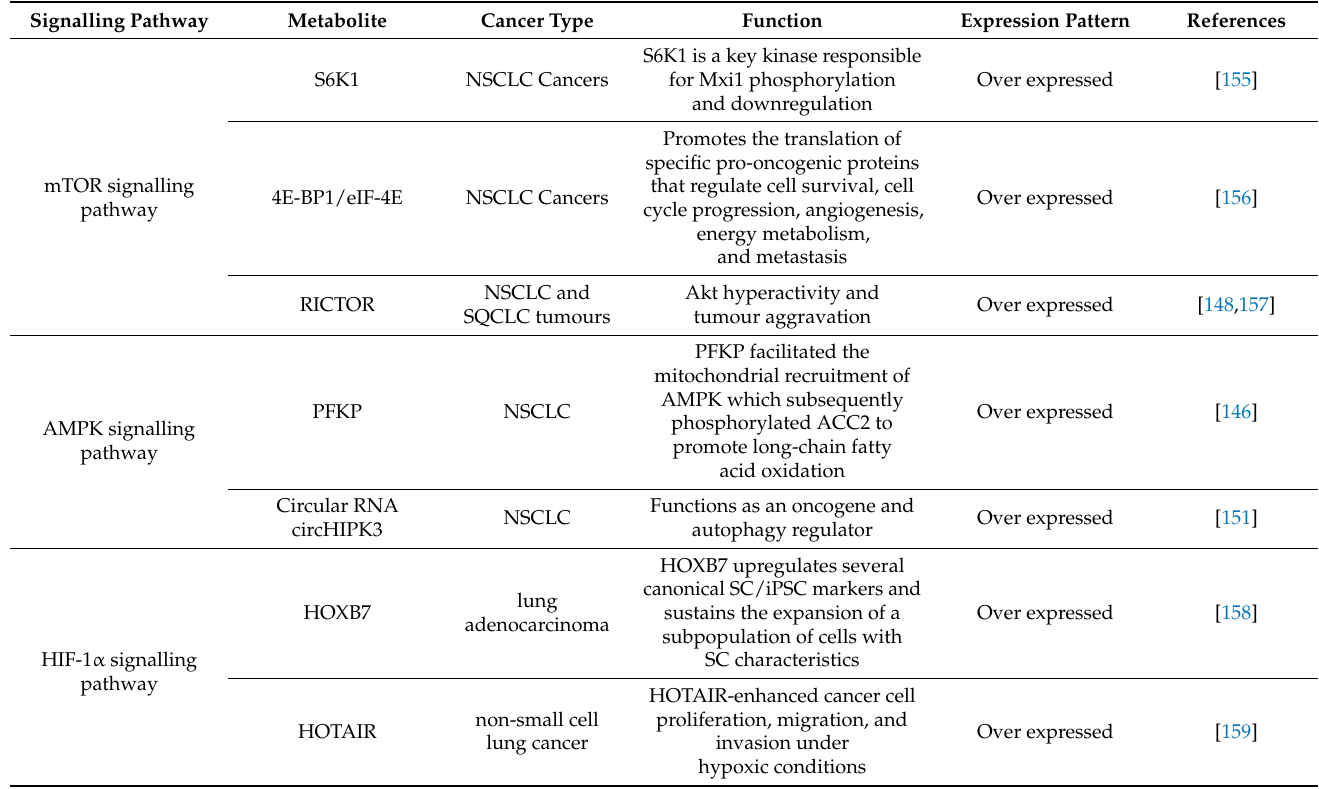
Table 2. Metabolites associated with different signalling pathways involved in the progression of lung